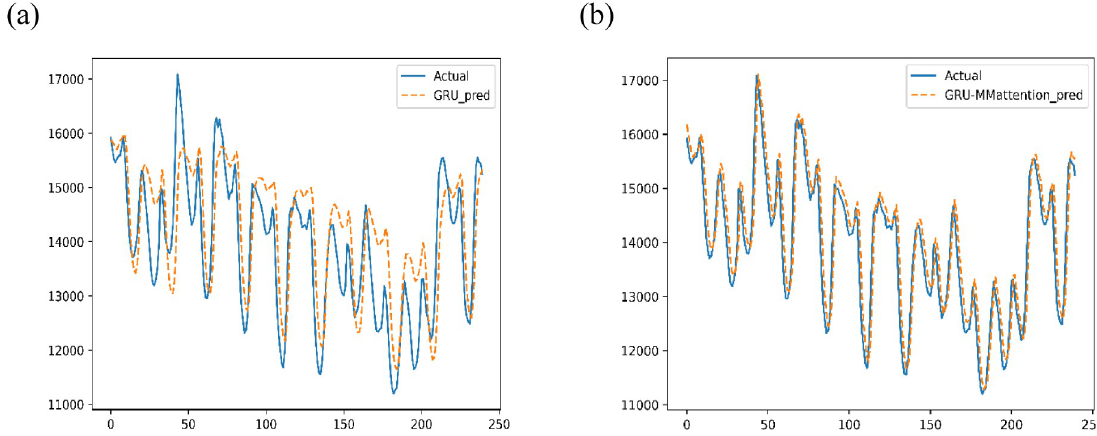
Fig 7. The prediction results in the test set. (a) GRU; (b) GRU-MMattention.